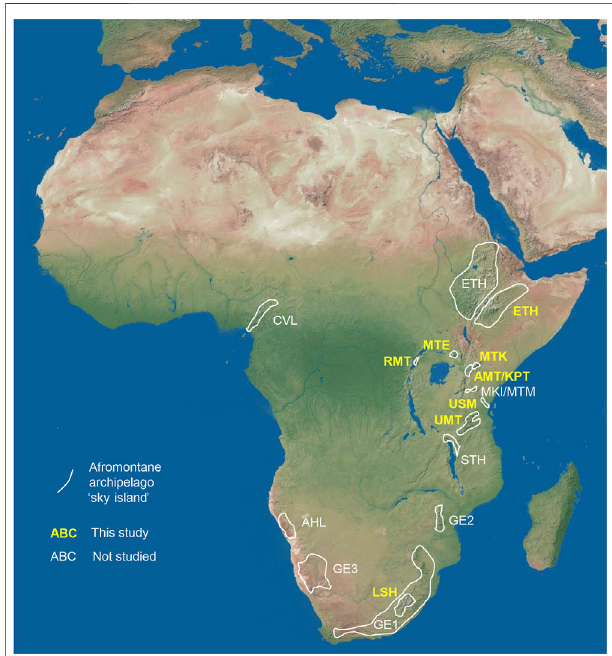
FIGURE 1 | Afromontane “ sky islands ” studied. The mountain ranges in sub-Saharan Africa covered in the current study are italicized and colored in yellow. Abbreviations: AHL, Angolan Highlands; AMT, Aberdares Mts.; CVL, Cameroon Volcanic Line; ETH, Ethiopian Highlands; GE1 – 3, Great Escarpment; Kinangop Plateau (KPT)-; LSH, Lesotho Highlands; MKI, Mt. Kilimanjaro;MTK,Mt.Kenya;MTM, Mt.Meru;MTE,Mt.Elgon;STH,Southern Tanzania Highlands; USM, Usambara Mts.; UMT, Udzungwa Mts.